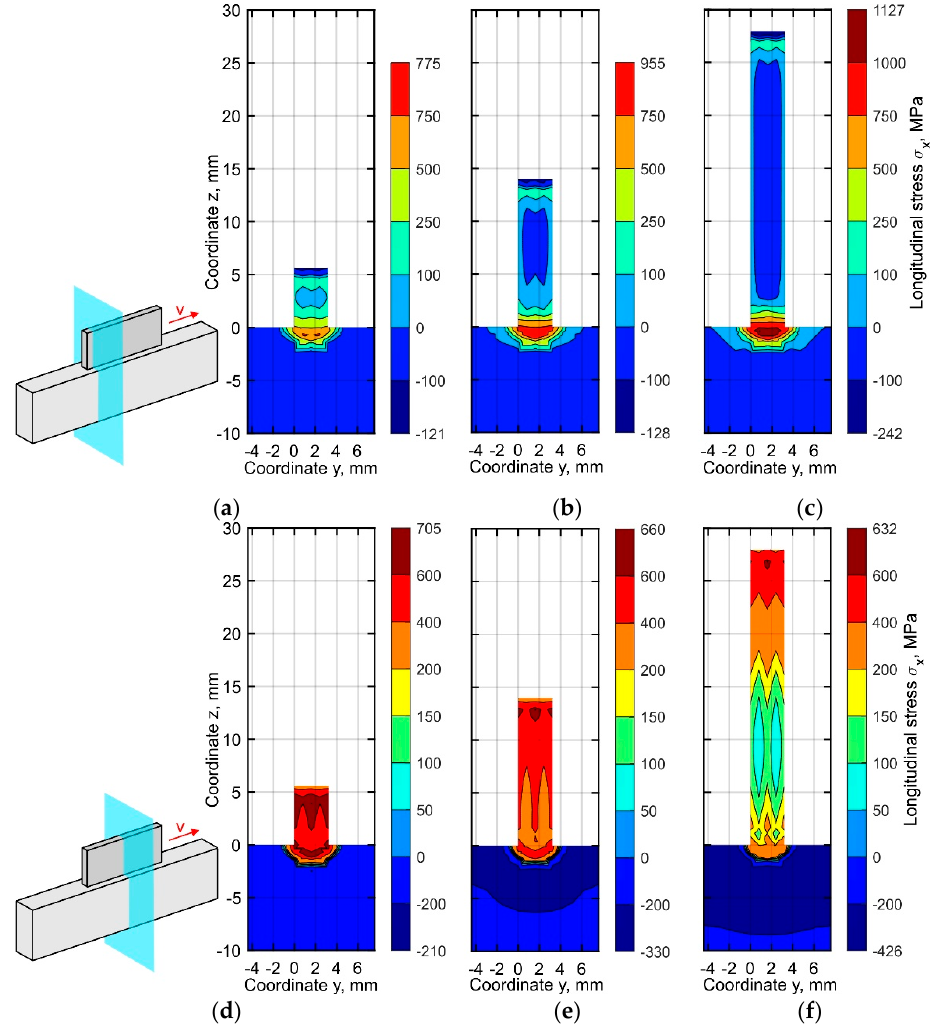
Figure 10. Longitudinal stress distribution in the cross-section ( a – c ) near the buildup end, ( d – f ) in the middle part at the time corresponding to the end of the cooling after ( a , d ) 10, ( b , e ) 25, and ( c , f ) 50 layers.